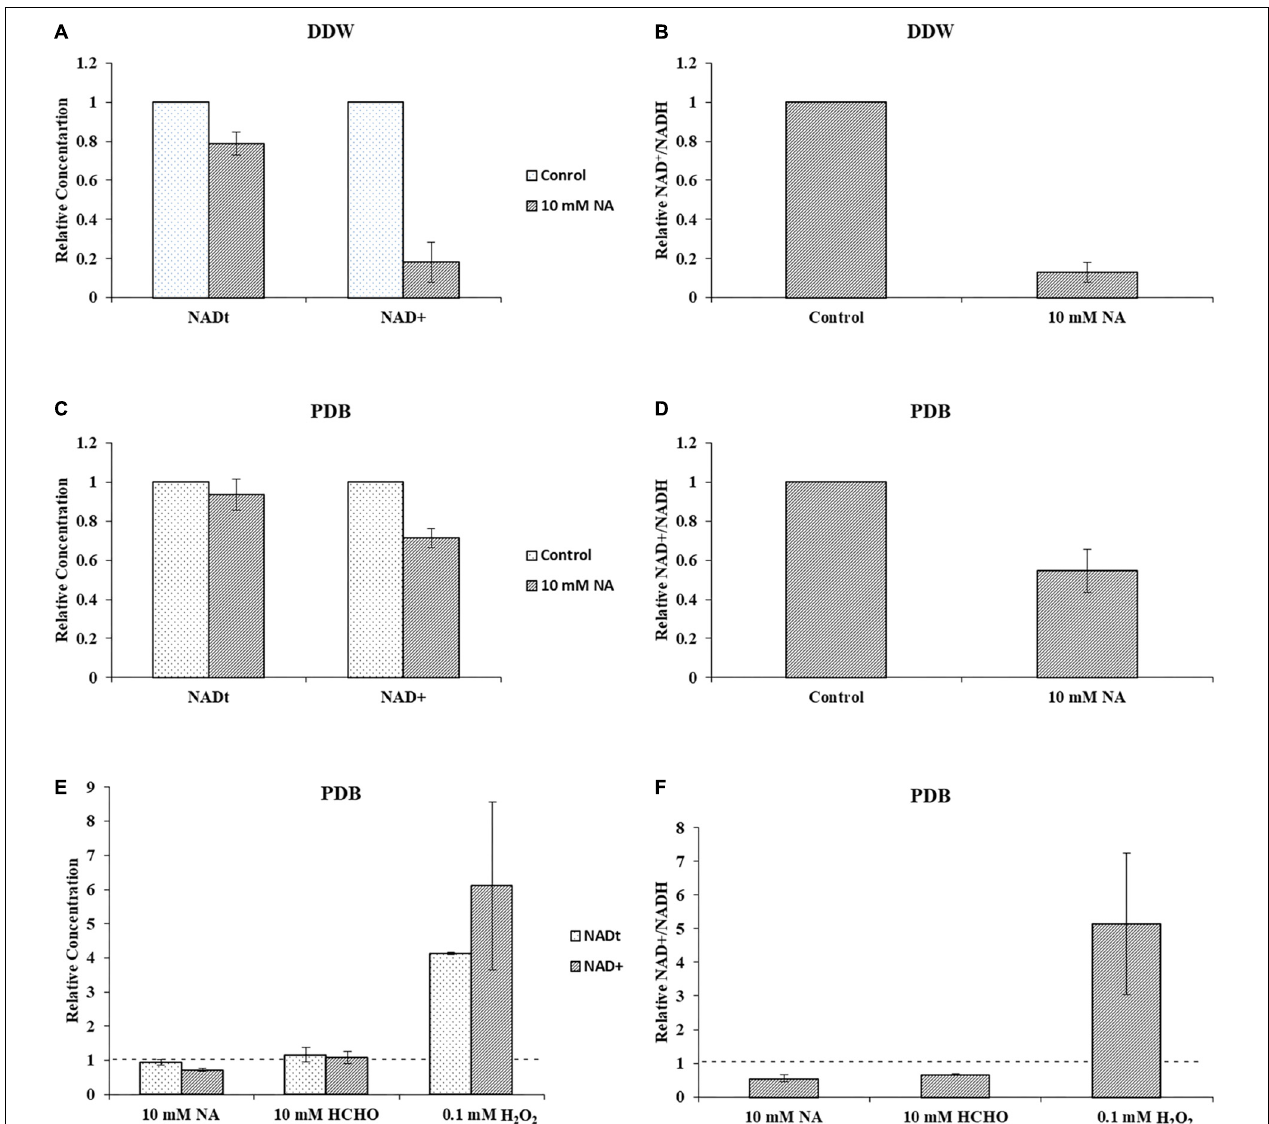
FIGURE 8 | NA inhibits NAD + biosynthesis and disturbs NAD + /NADH ratio in F. oxysporum. (A) The effect of 10 mM NA on total NAD and NAD + concentrations in DDW is presented. (B) The effect of 10 mM NA on NAD + /NADH ratio in DDW is presented. (C) The effect of 10 mM NA on total NAD and NAD + concentrations in PDB is presented. (D) The effect of 10 mM NA on NAD + /NADH ratio in PDB is presented. (E) Effect of 10 mM NA, 10 mM formaldehyde (HCHO) and 0.1 mM H 2 O 2 on total NAD and NAD + concentration of conidia grown in PDB. (F) Effect of 10 mM NA, 10 mM HCHO, and 0.1 mM H 2 O 2 on NAD + /NADH ratio. Conidia were grown in DDW and PDB for 24 and 5 h, respectively, followed by 3 h of NA exposure. To study the effect of HCHO, conidia were grown in PDB for 5 h, followed by 3 h of HCHO exposure. To study the effect of H 2 O 2 , conidia were grown in PDB for 2 h, followed by 30 min of H 2 O 2 exposure. NAD was extracted and measured as described in Materials and Methods. The vertical bars represent relative values with control as reference. Dotted lines represent untreated controls. Values are mean ± SD. Vertical lines represent standard error